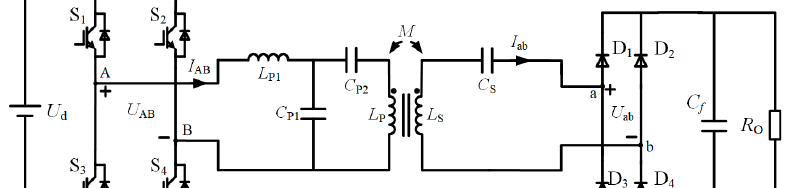
Figure 2. Circuit diagram of LCC-S-compensated IPT system.